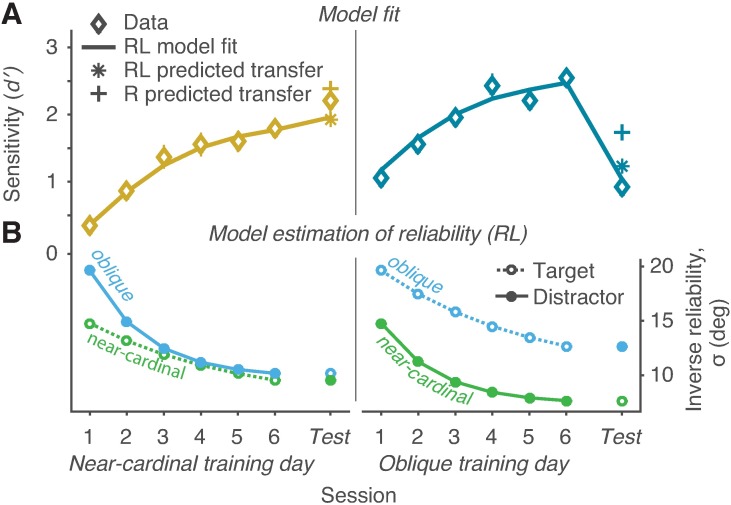
Model performance and estimated reliability for the near-cardinal (left column) and oblique (right column) groups.(A) Curves show the Reliability-and-Learning model fit to the sensitivity data (diamonds) averaged across SOAs for each training day (1–6) and orientation transfer test (Or). Reliability-and-Learning (stars) and Reliability (plus signs) show transfer test predictions based on fits to the training days only. Error bars are within subject ±1 standard error of the mean [27]. (B) Estimated inverse reliability (σ) for the target and distractor stimulus representations as a function of training day and orientation test. RL: Reliability-and-Learning model; R: Reliability model.